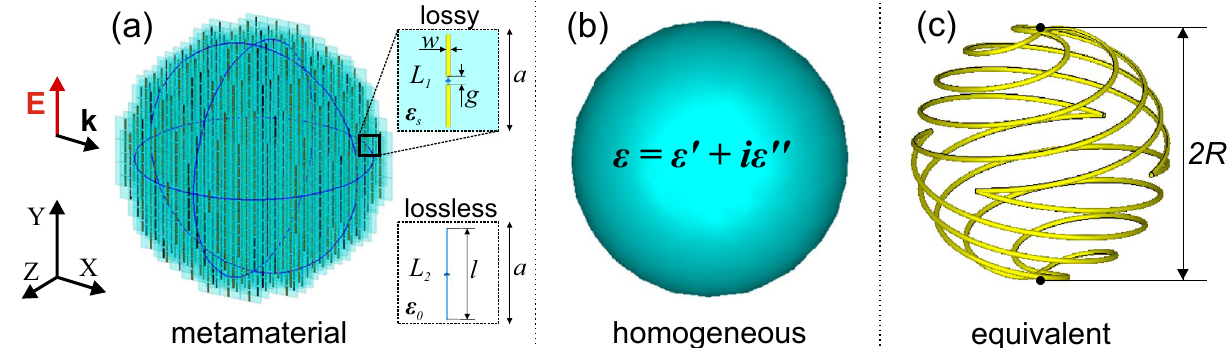
Figure 1. Electromagnetic scatterers. ( a ) Metamaterial-based volumetric scatterer made of inductively loaded dipoles. ( b ) Homogenized counterpart of the metamaterial structure. ( c ) Surface impedance equivalent—a 4-wire spherical